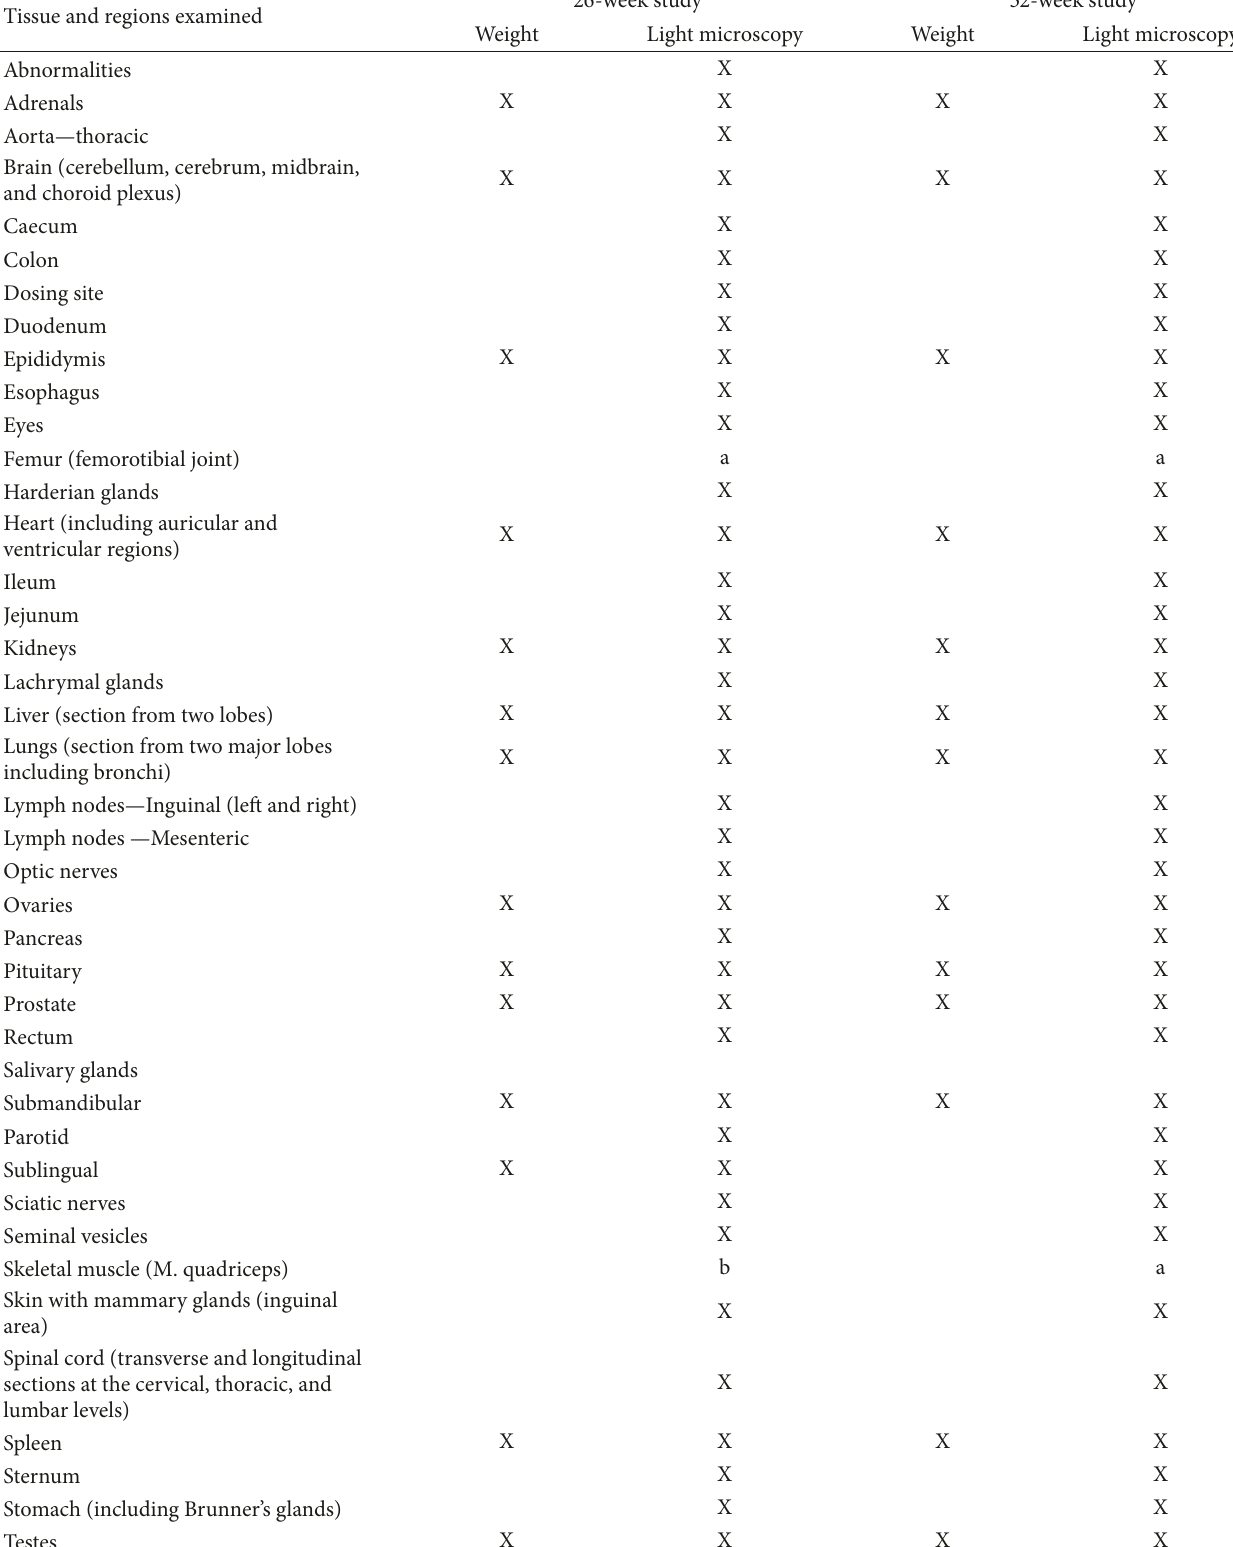
Table 3: List of collected